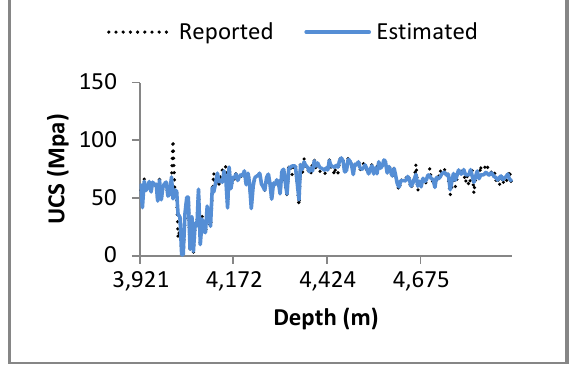
Figure 4. Comparison between reported and estimated values for the model in test data for uniaxial compressive strength (UCS).